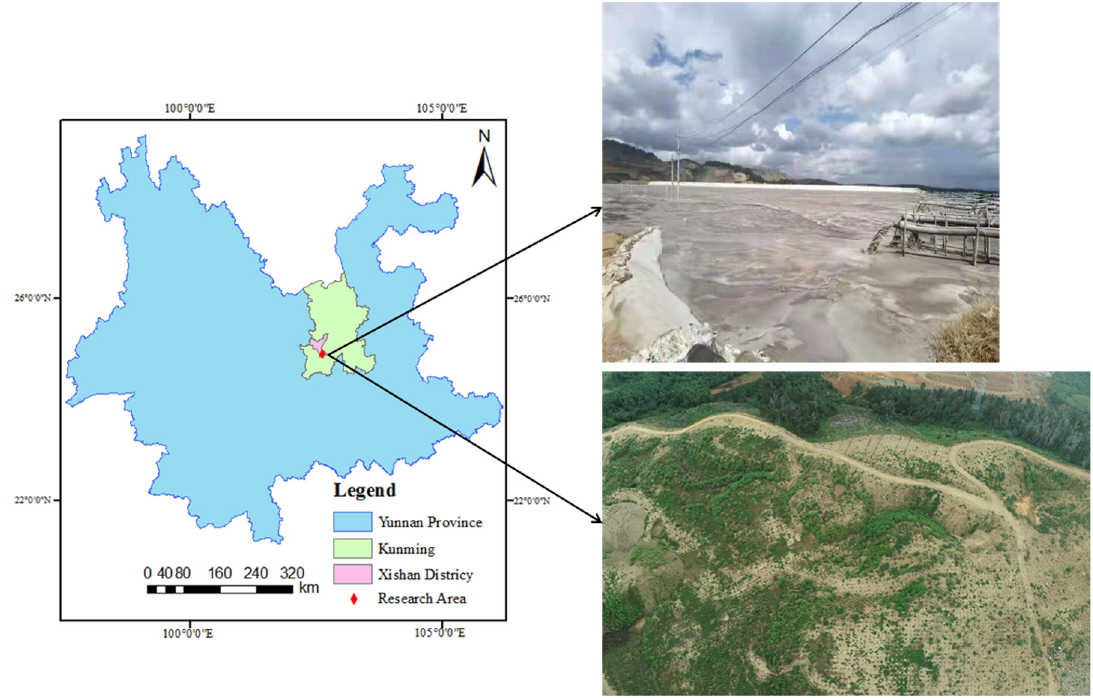
Figure 1. Position of research area.